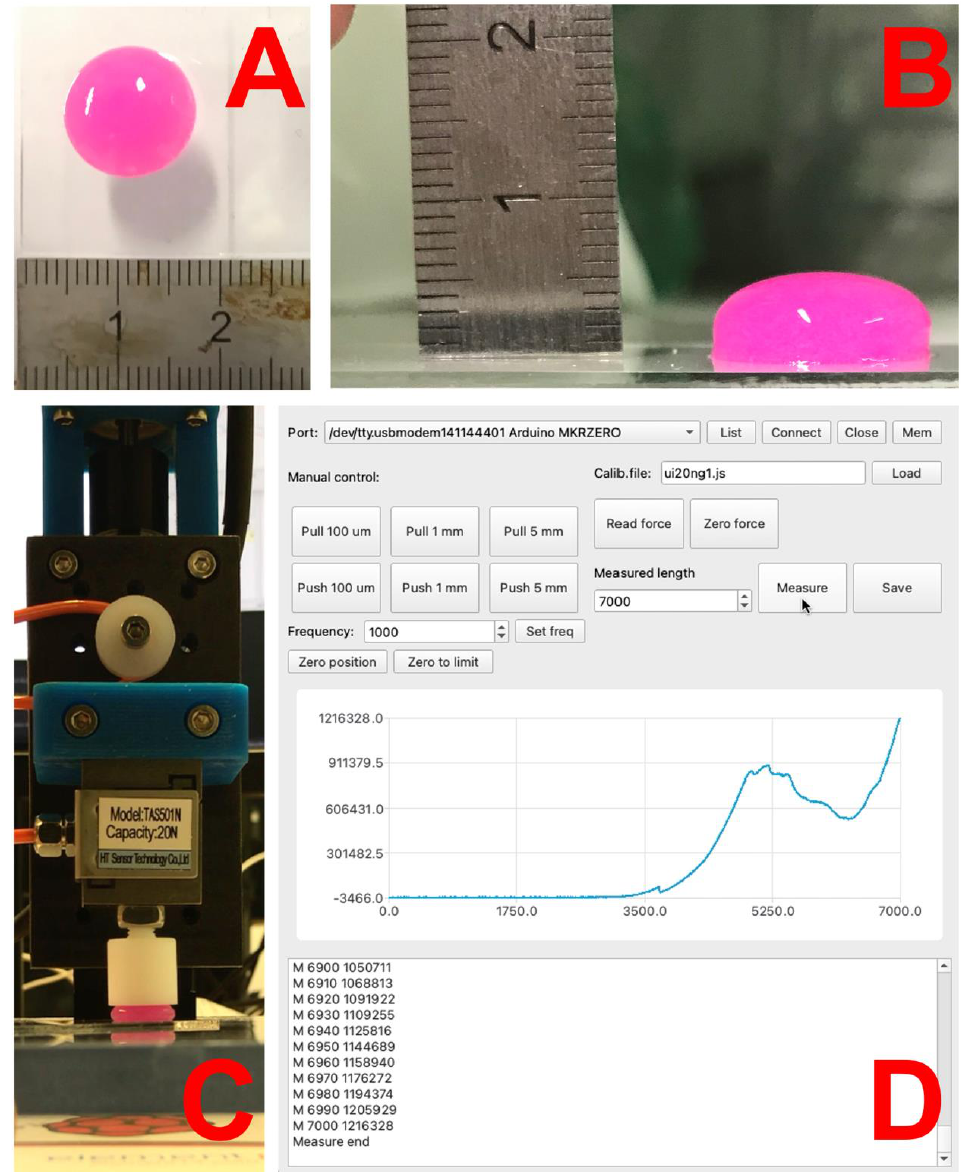
Figure 14. Printed bioinks on microscope glass: ( A ) top view; ( B ) side view. Estimation of mechanical properties: ( C ) custom testing device with linear actuator and force sensor; ( D ) custom control and acquisition software.